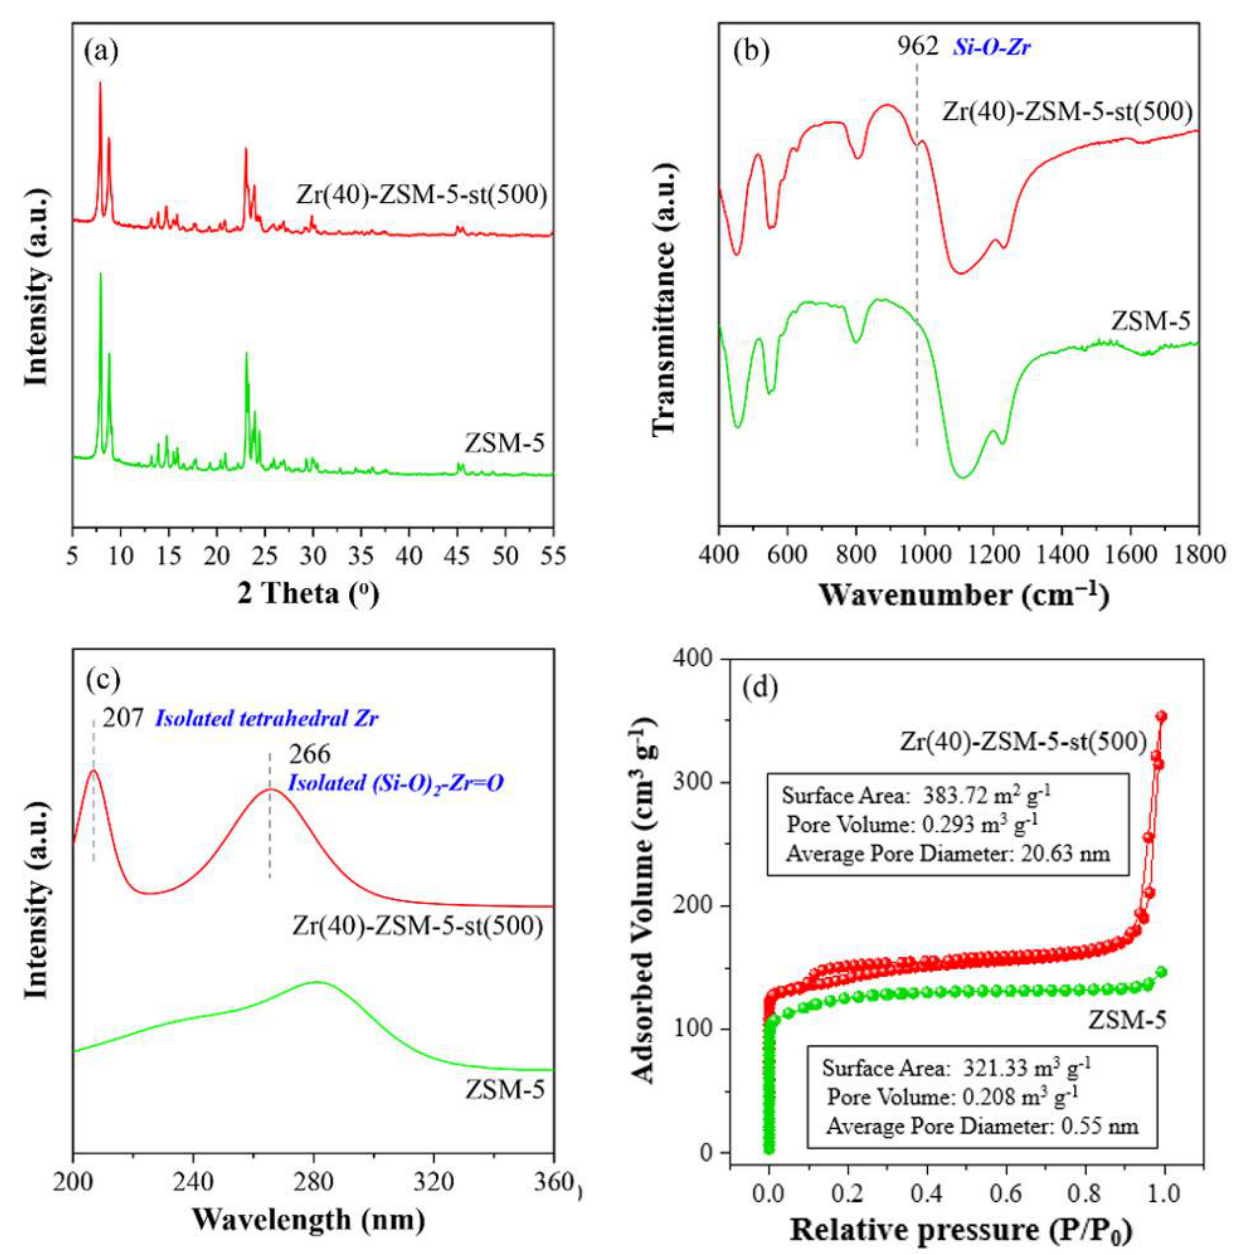
Figure 1. ( a ) X-ray diffraction (XRD), ( b ) Fourier transform infrared (FT-IR), ( c ) ultraviolet-visible spectra as well as ( d ) N 2 adsorption–desorption isotherms for ZSM-5 with Zr(40)-ZSM-5-st(500) cat- alysts.